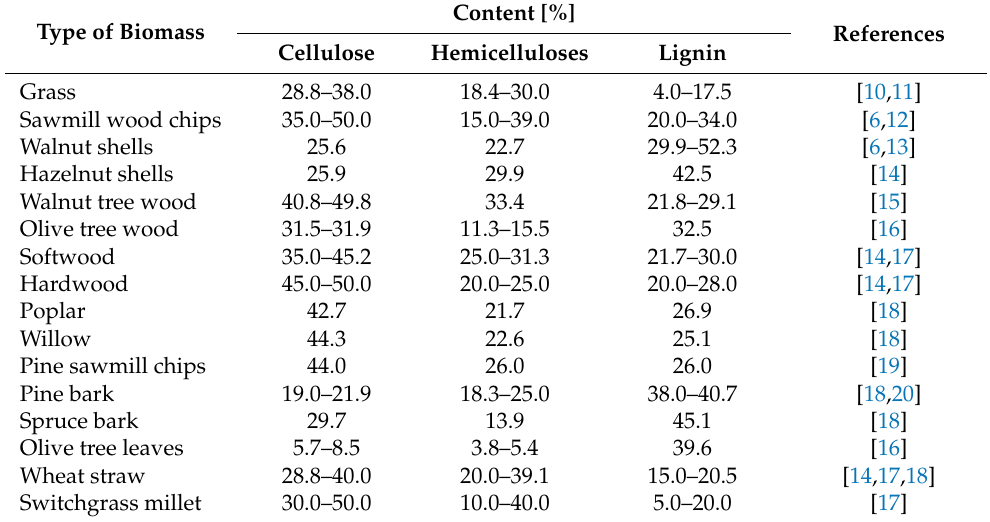
Table 1. Content of cellulose, hemicelluloses, and lignin in different types of lignocellulosic biomass.